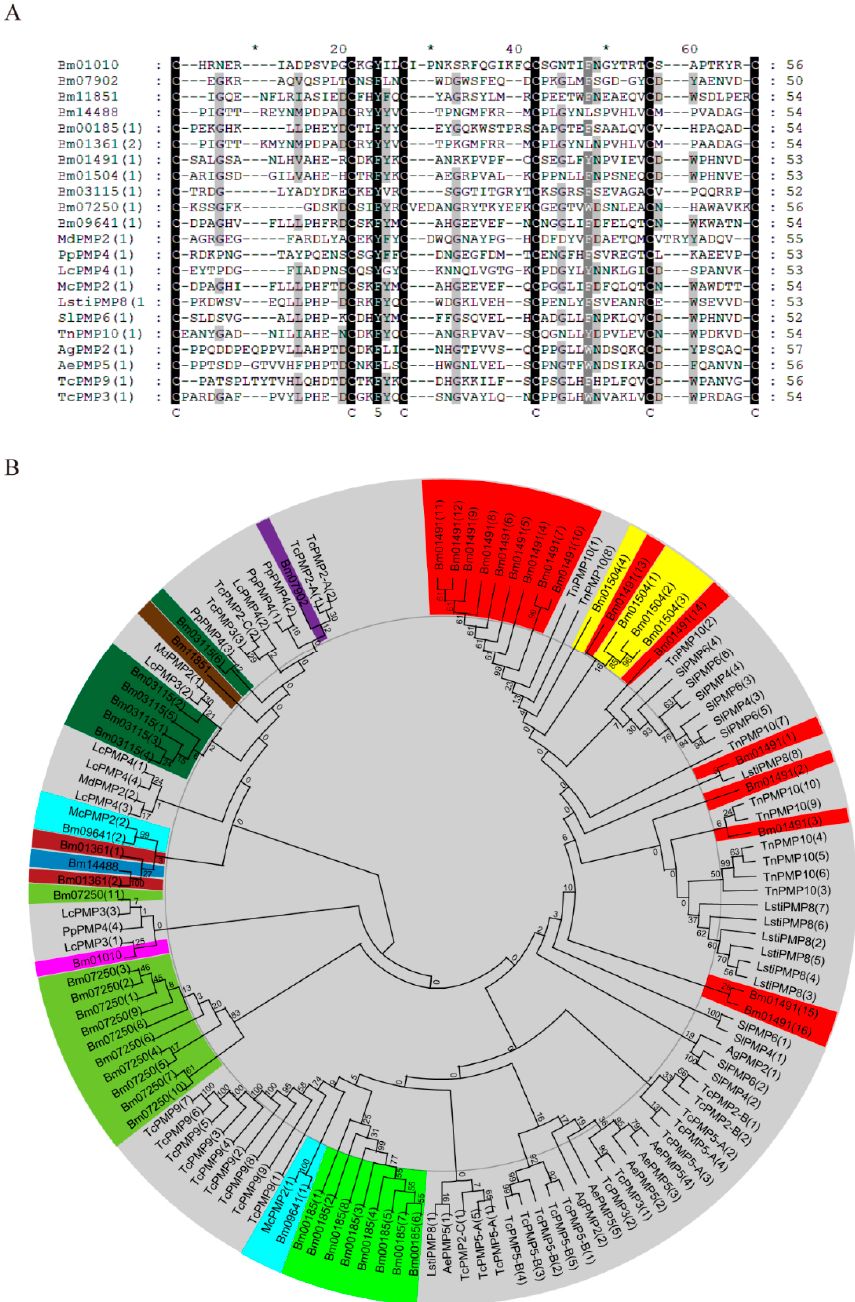
Figure 1. Phylogenetic analysis and multiple sequence alignment of CBDs in peritrophins. Species included Aedes aegypti (Aa), Anopheles gambiae (Ag), Bombyx mori (Bm), Loxostege sticticalis Linne (Lsti), Lucilia cuprina (Lc), Mamestra configurata (Mc), Mayetiola destructor (Md), Phlebotomus papatasi (Pp), Spodoptera litura (Sl), Tribolium castaneum (Tc), Trichoplusia ni (Tn). ( A ) Amino acid sequence alignment of first CBD in peritrophins. The CBD sequence comprised 52–56 amino acid residues, and a consensus of conserved cysteines (C) and spaces (X): CX 11-15 CX 5 CX 9-14 CX 11-12 CX 6-7 C. Black shading indicates cysteine and other conserved residues in CBDs. The less-conserved amino acids are shown in shades of gray; ( B ) Phylogenetic tree of CBDs from several species. Bombyx mori peritrophins include Bm01491 (red), Bm11851 (brown), Bm09641 (sky blue), Bm01504 (yellow), Bm00185 (lime), Bm07250 (yellow green), Bm01010 (fuchsia), Bm07902 (purple), Bm14488 (cyan), Bm01361 (dark red), Bm03115 (dark green). The accession numbers of all proteins are listed in Table S3.